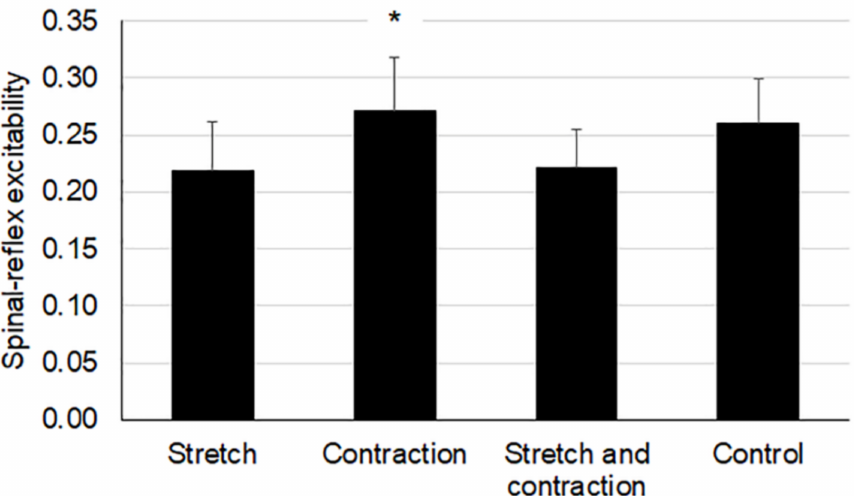
Figure 3. Change in quadriceps spinal-reflex excitability (time-collapsed: condition effect: F 3,143 = 2.39, p = 0.07). * Different from the stretch condition ( p = 0.03, ES = 0.35, 19%) and stretch and contraction condition ( p = 0.05, ES = 0.36, 18%).